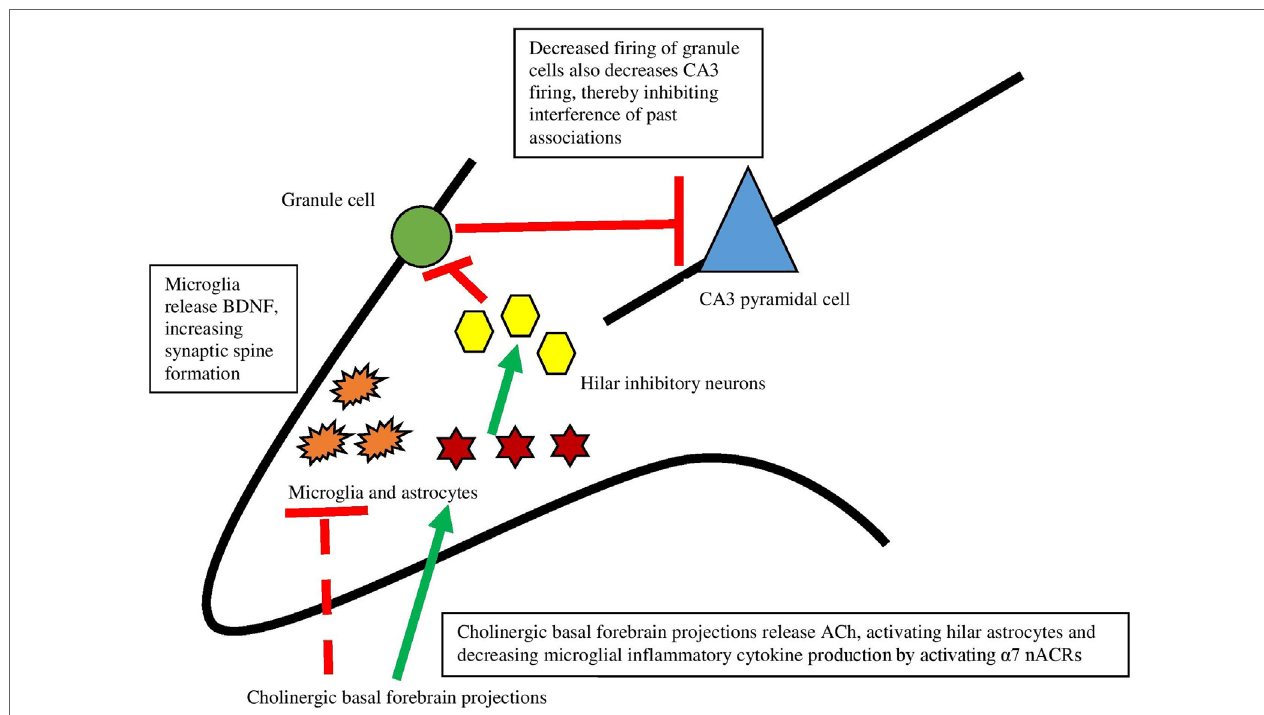
FiGURe 2 | The interaction between the cholinergic system and glia and its impact on the hippocampus. Dotted lines represent cytokine effects, and solid lines represent cell activation/firing. Cholinergic basal forebrain projections release ACh and both decrease cytokine release from microglia and activate hilar astrocytes. Those astrocytes activate inhibitory interneurons, which decreases firing from granule cells. This decreased firing leads to decreased firing of CA3 pyramidal cells, preventing interference of past associations in encoding. Based largely on Hasselmo (74) and Pabst et al.